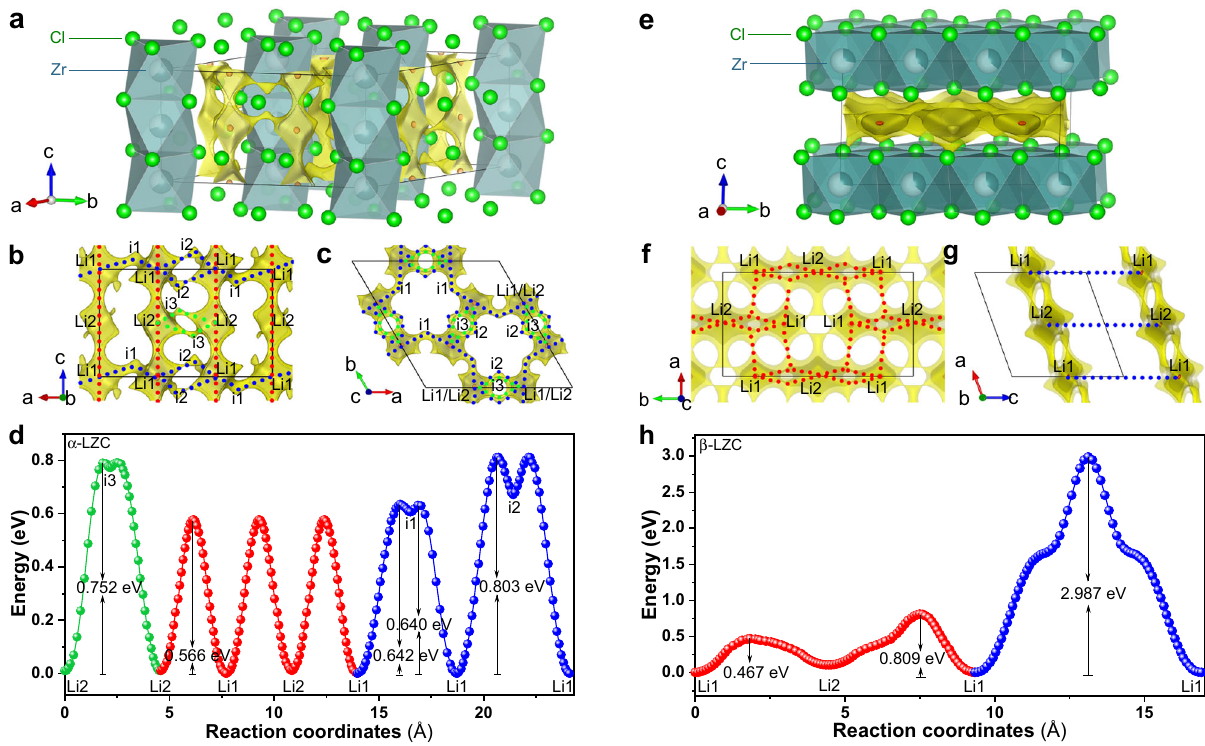
Fig. 4 BVSE analysis of Li-ion migration within the α -LZC and β -LZC structures. a , e The crystal structures of α -LZC ( a ) and β -LZC ( e ) superimposed with the Li-ion potential map. b , c , f , g Li-ion migration pathways of α -LZC ( b , c ) and β -LZC ( f , g ). d , h Energy pro fi les of the migration pathways in α -LZC ( d ) and β -LZC ( h ). Each pathway in b – c and f – g corresponds to the energy pro fi le of the same color in d and h , respectively. The crystal structures and potential isosurfaces are visualized using VESTA 56